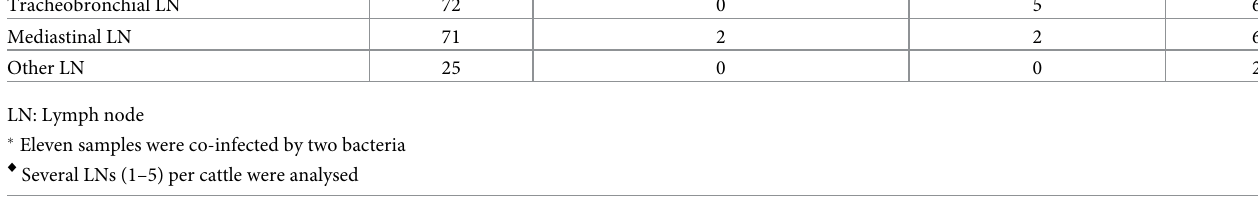
Of the 240 LN from control animals without bTB-like lesions and a negative first-line PCR results, 96% remained completely negative to the second line diagnosis (Table 4). Only two